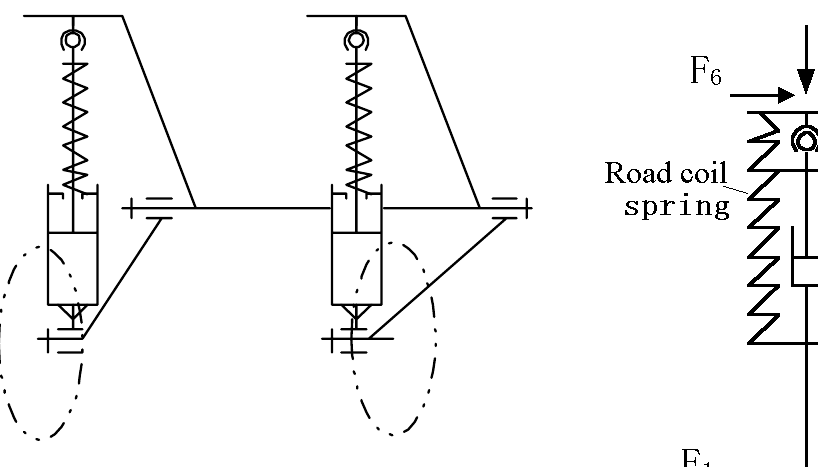
Fig. 1. The rear suspensions system with shock absorbers.